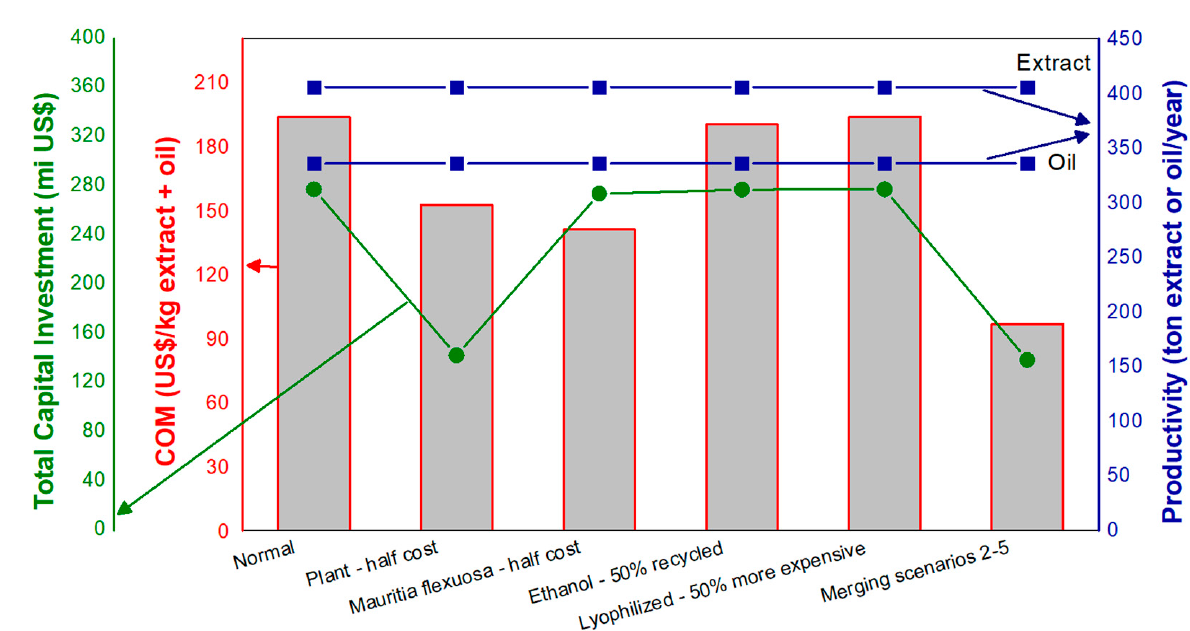
Figure 3. COM, productivity, and total capital investment to produce oil and phenolic ‐ rich extracts by the sequential two ‐ stage process using supercritical and conventional solvent extraction (SFE+CSE).